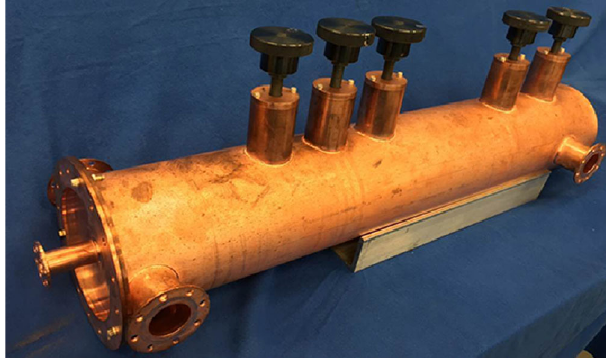
FIG. 13. Prototype cavity made of copper.